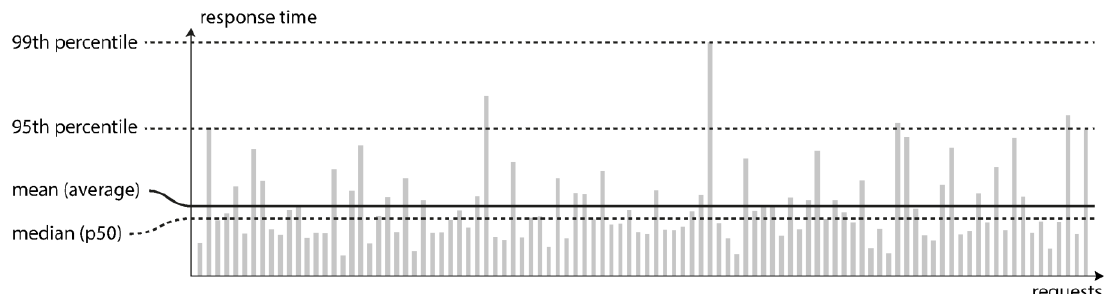
Figure 10. The percentiles and mean of response times for a request in the PSA.